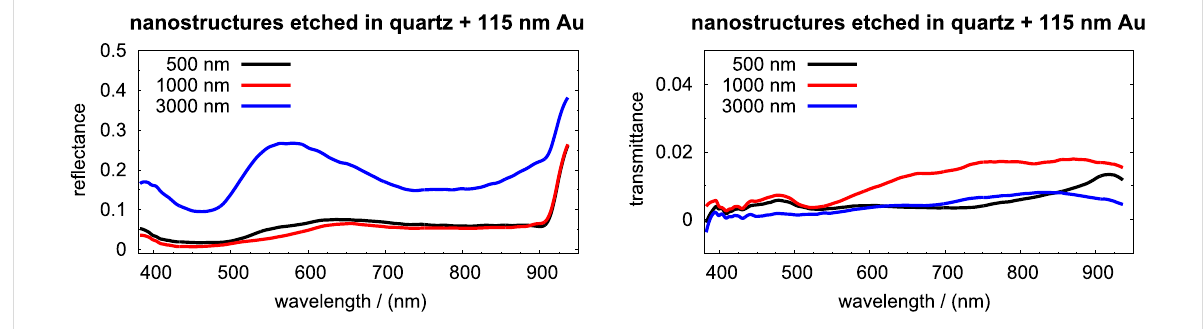
Figure 8: Reflectance (left) and transmittance (right) of triangular nanostructures etched in quartz and coated with 115 nm of gold. The diameter of the PS spheres used for the fabrication of the Cr masks is indicated in each spectrum.